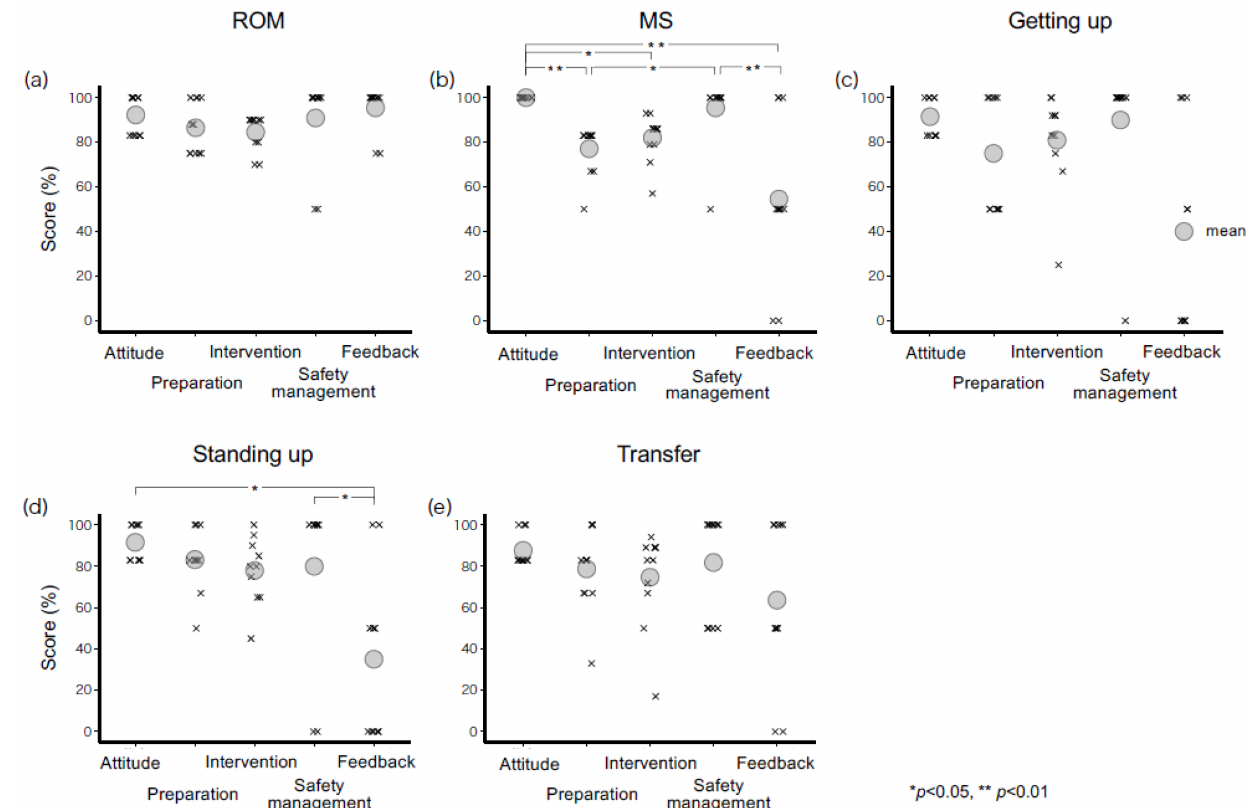
Figure 2. Achievement rate for each classification of each task; The Feedback category showed the lowest rate. Significant differences were indicated between the categories of Muscle strengthening and Standing up and sitting down